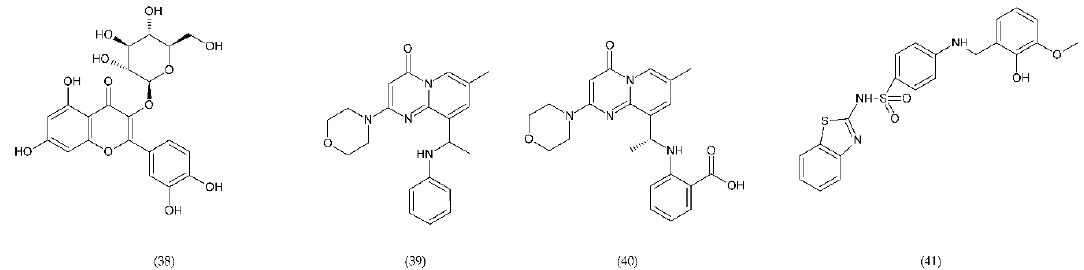
Figure 14. Inhibitors of PDI and PI3K β : Isoquercetin (38), TGX221 (39), and AZD6482 (40); inhibitor of 12-lipoxygenase ML355 (41).